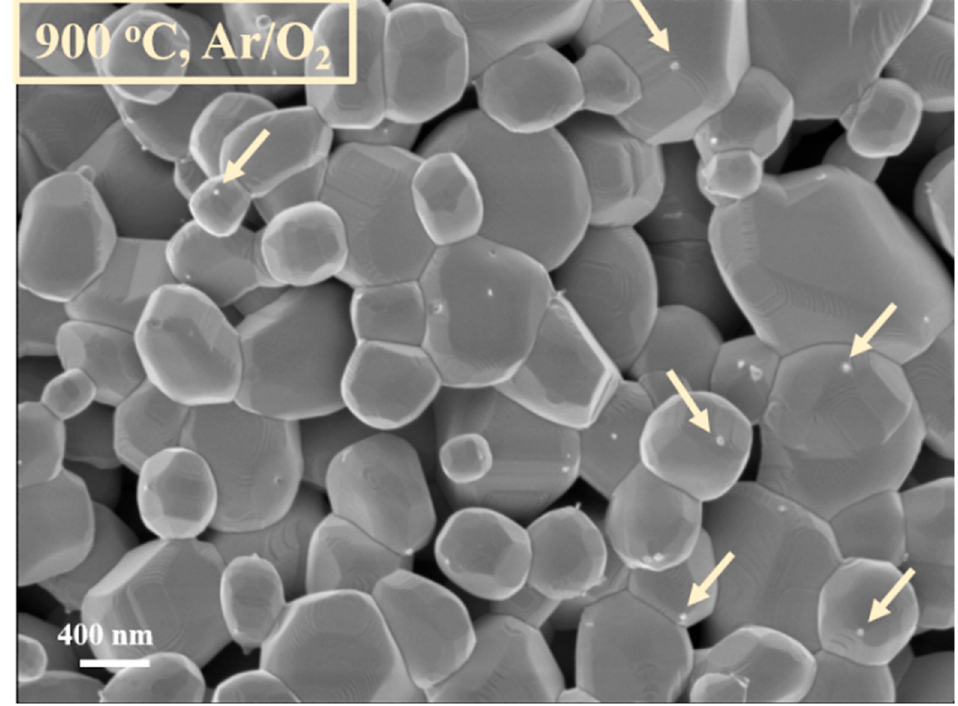
Figure 4. Tungsten oxide particles, obtained after the oxidation process.